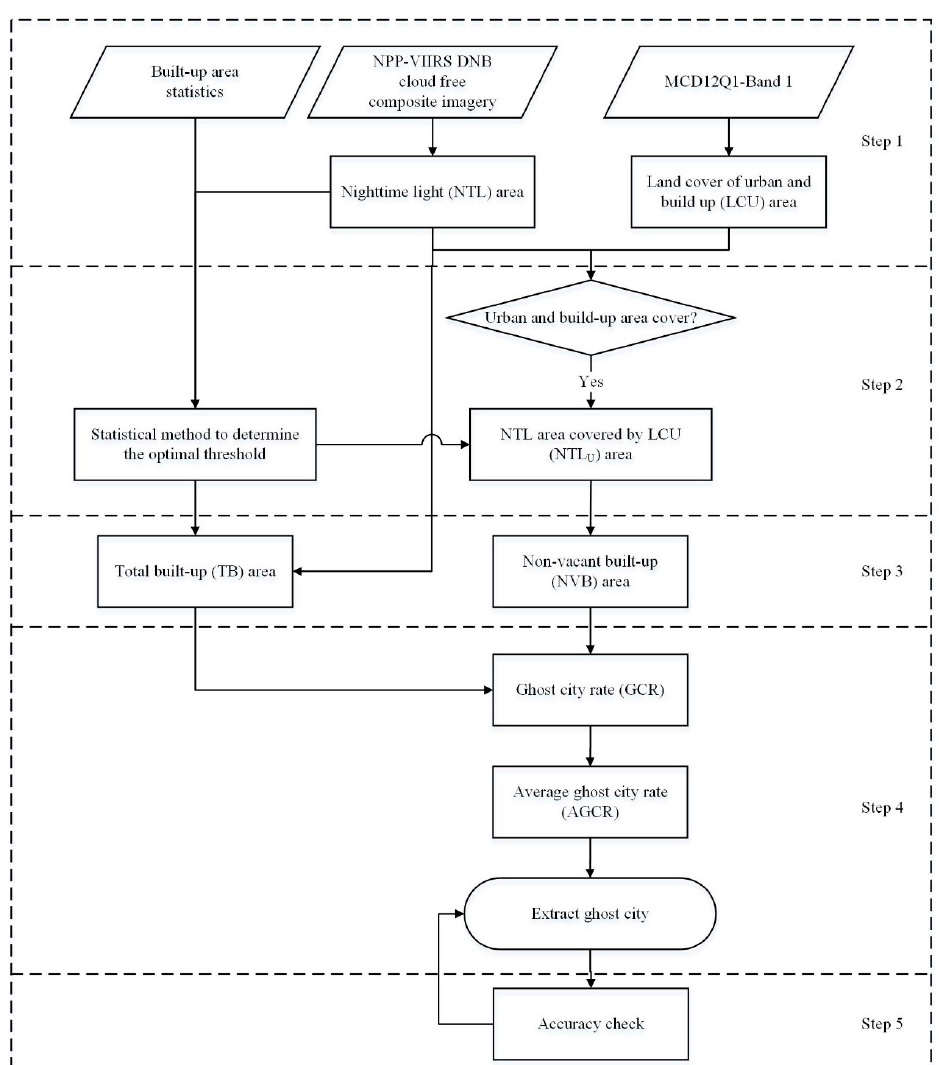
Figure 2. Workflow of the ghost city extraction and rate estimation.